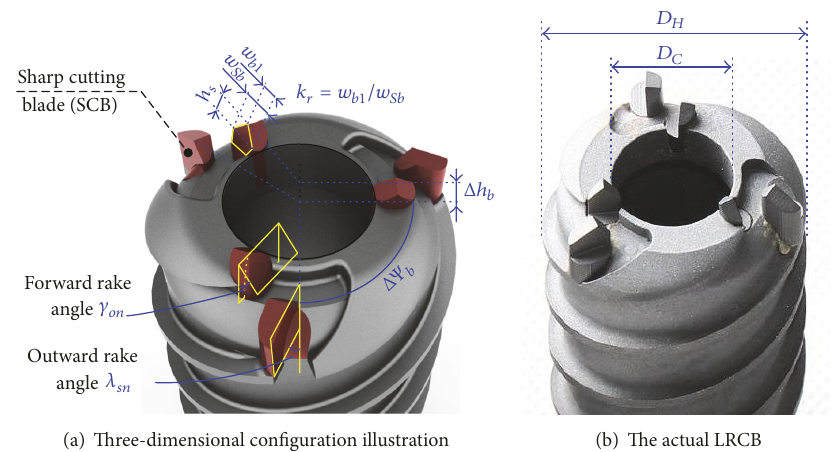
Figure 1: Three-dimensional configuration illustration of the LRCB and the actual LRCB.